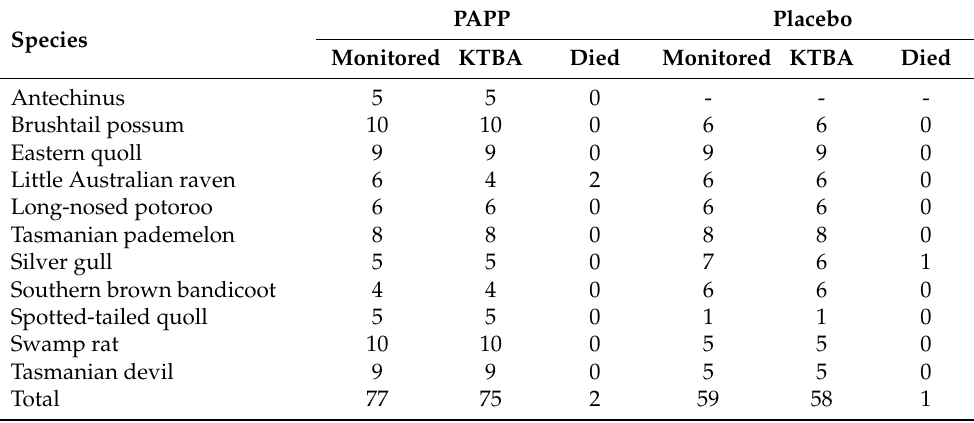
Table 3. Summary of fate of animals known to be alive (KTBA) for a 10-day period after release as determined from recapture, direct observation within captive colony or radio-tracking data for all animals dosed with PAPP dissolved in DSMO (PAPP) or those given a placebo consisting of DMSO alone